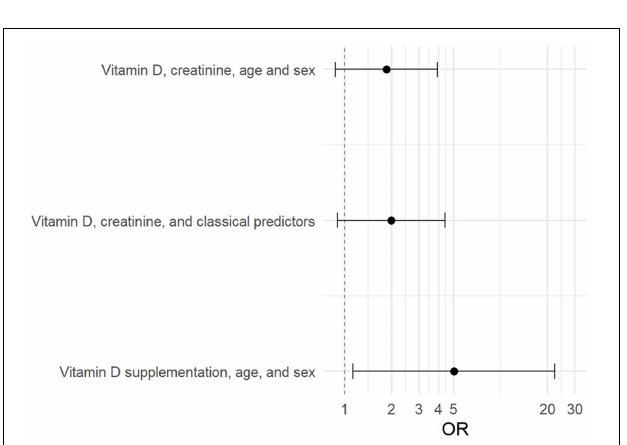
included patients were female. The median age was 66.6 years.